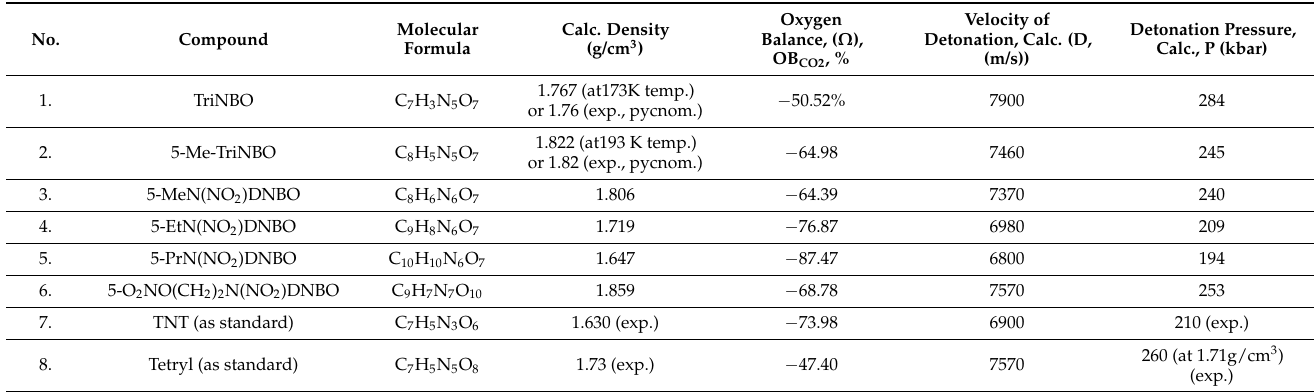
Table 4. The main calculated energetic properties of the synthesized 1,3-dihydro- 2H -benzimidazol-2- one